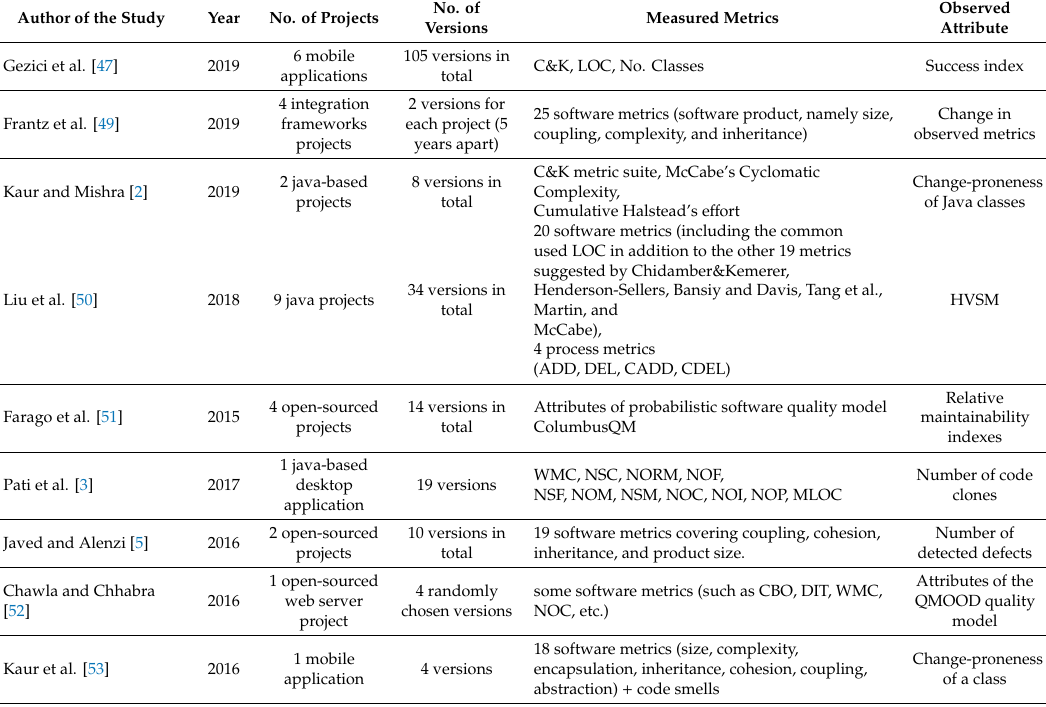
Table 2. A summary of related